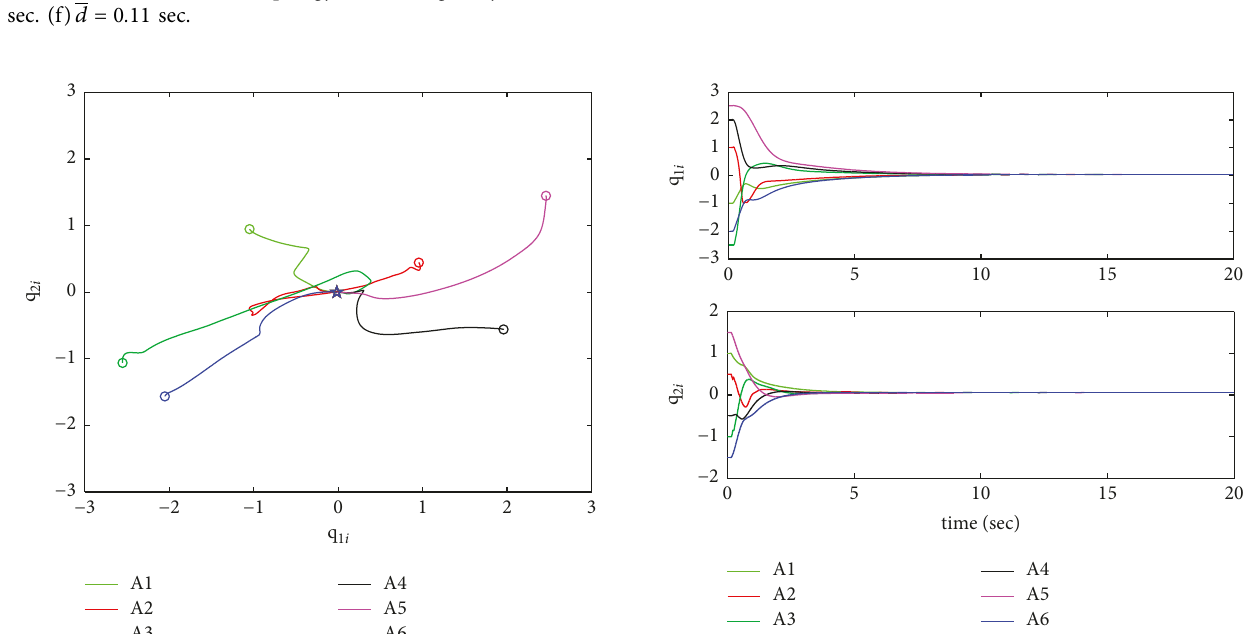
Figure 4: Multiagent trajectories and the fault-free case (AFSC).